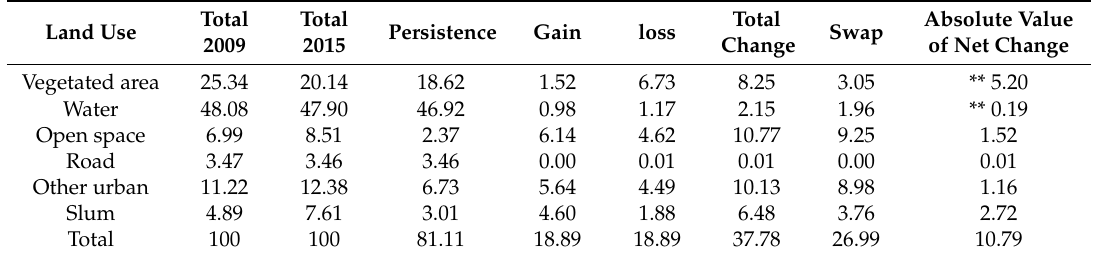
Table 7. Land use and land cover changes in the period 2009–2015 (%).